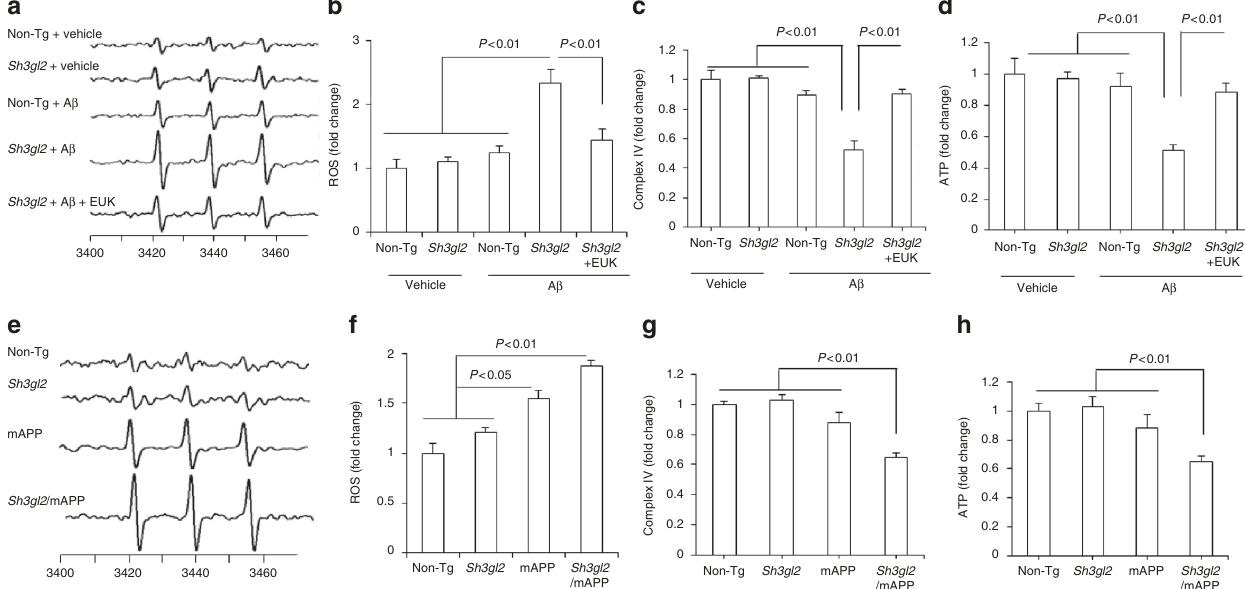
Fig. 3 Effect of antioxidant on EP/A β -mediated ROS production and mitochondrial dysfunction in brain in vivo and brain slices in vitro. a The peak height in the spectrum indicates the levels of ROS. Representative spectrum of EPR in indicated mice brain slices perfused with A β or vehicle in the presence/absence of antioxidant EUK-134 (EUK). Brain slices from indicated Tg mice were pretreated with EUK (500nM) for 5 min before A β perfusion (50nM for 1h). b Data are presented as fold increase relative to vehicle-treated non-Tg mice slices. Mitochondrial complex IV activity ( c ) and ATP levels ( d ) were demonstrated in the indicated hippocampus treated with vehicle or A β in the presence/absence of EUK. Date are shown as mean ± s.e.m., n = 3 per group (one-way ANOVA in b – d ). e Representative spectra of EPR in the indicated Tg mice at 5 – 6 months of age . f Quanti fi cation of EPR spectra in the indicated mice brain. Data are expressed as fold increase relative to non-Tg mice. Date are shown as mean ± s.e.m., n = 5 mice per group (one-way ANOVA in f ). Mitochondrial complex IV activity ( g ) and ATP levels ( h ) in indicated mice were assayed. Data are shown as mean ±s.e.m., n = 6 – 10 mice per group (one-way ANOVA in g – h